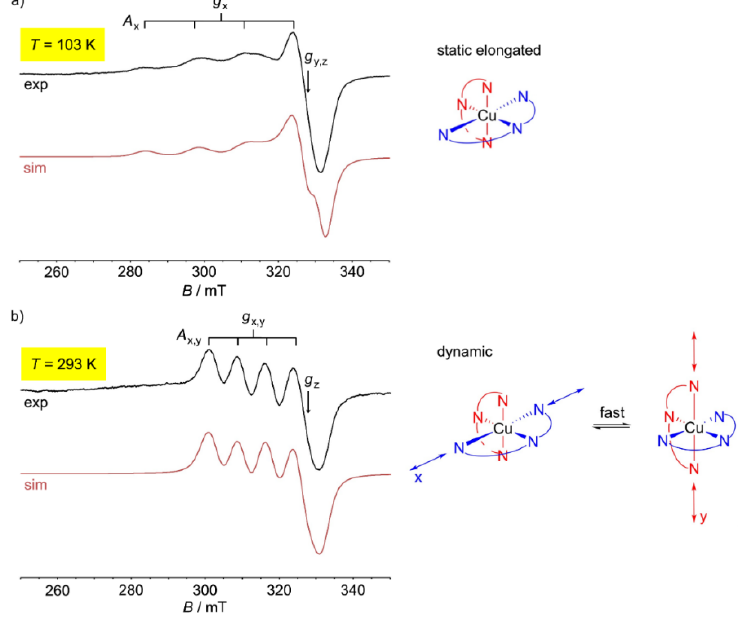
Figure 4. ( a ) X-band powder EPR spectrum of [Cu 0.875 Fe 0.125 (ddpd) 2 ][BF 4 ] 2 at 103 K, simulation in